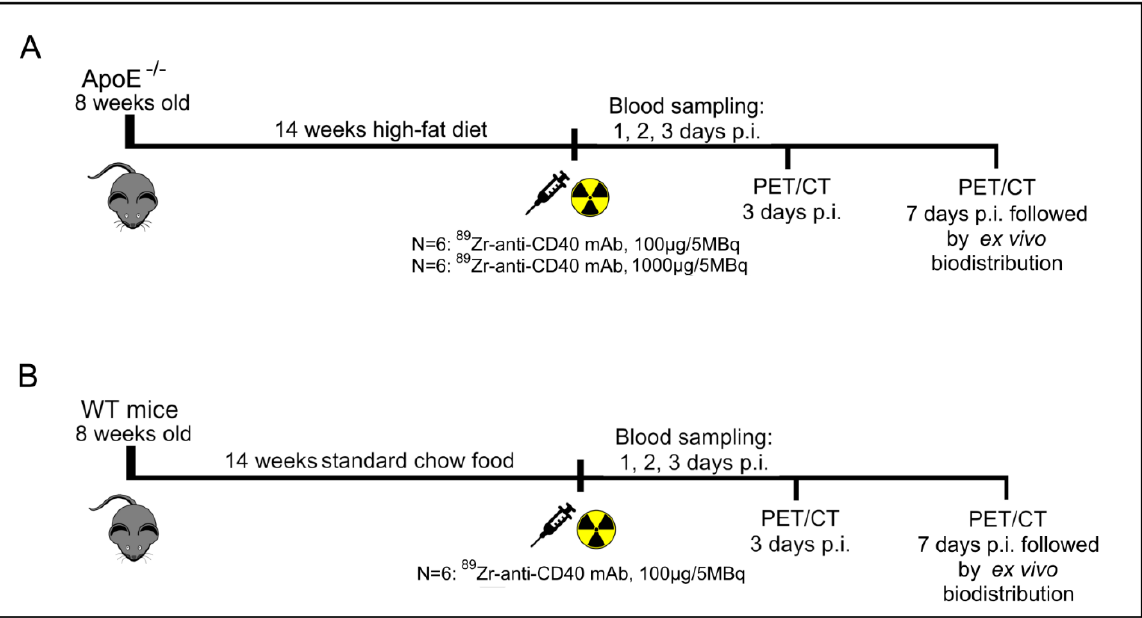
CD40 mAb in the aortic arch of ApoE −/− compared to the WT mice, we quantified the up-